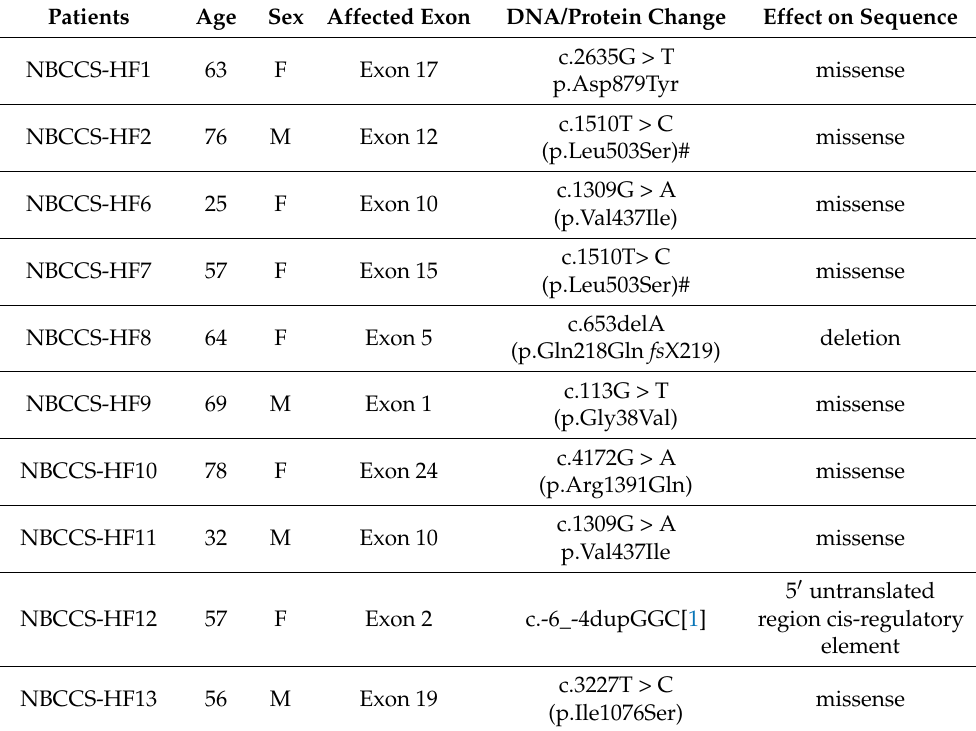
Table 1. Mutations found in nevoid basal cell carcinoma syndrome (NBCCS) cases